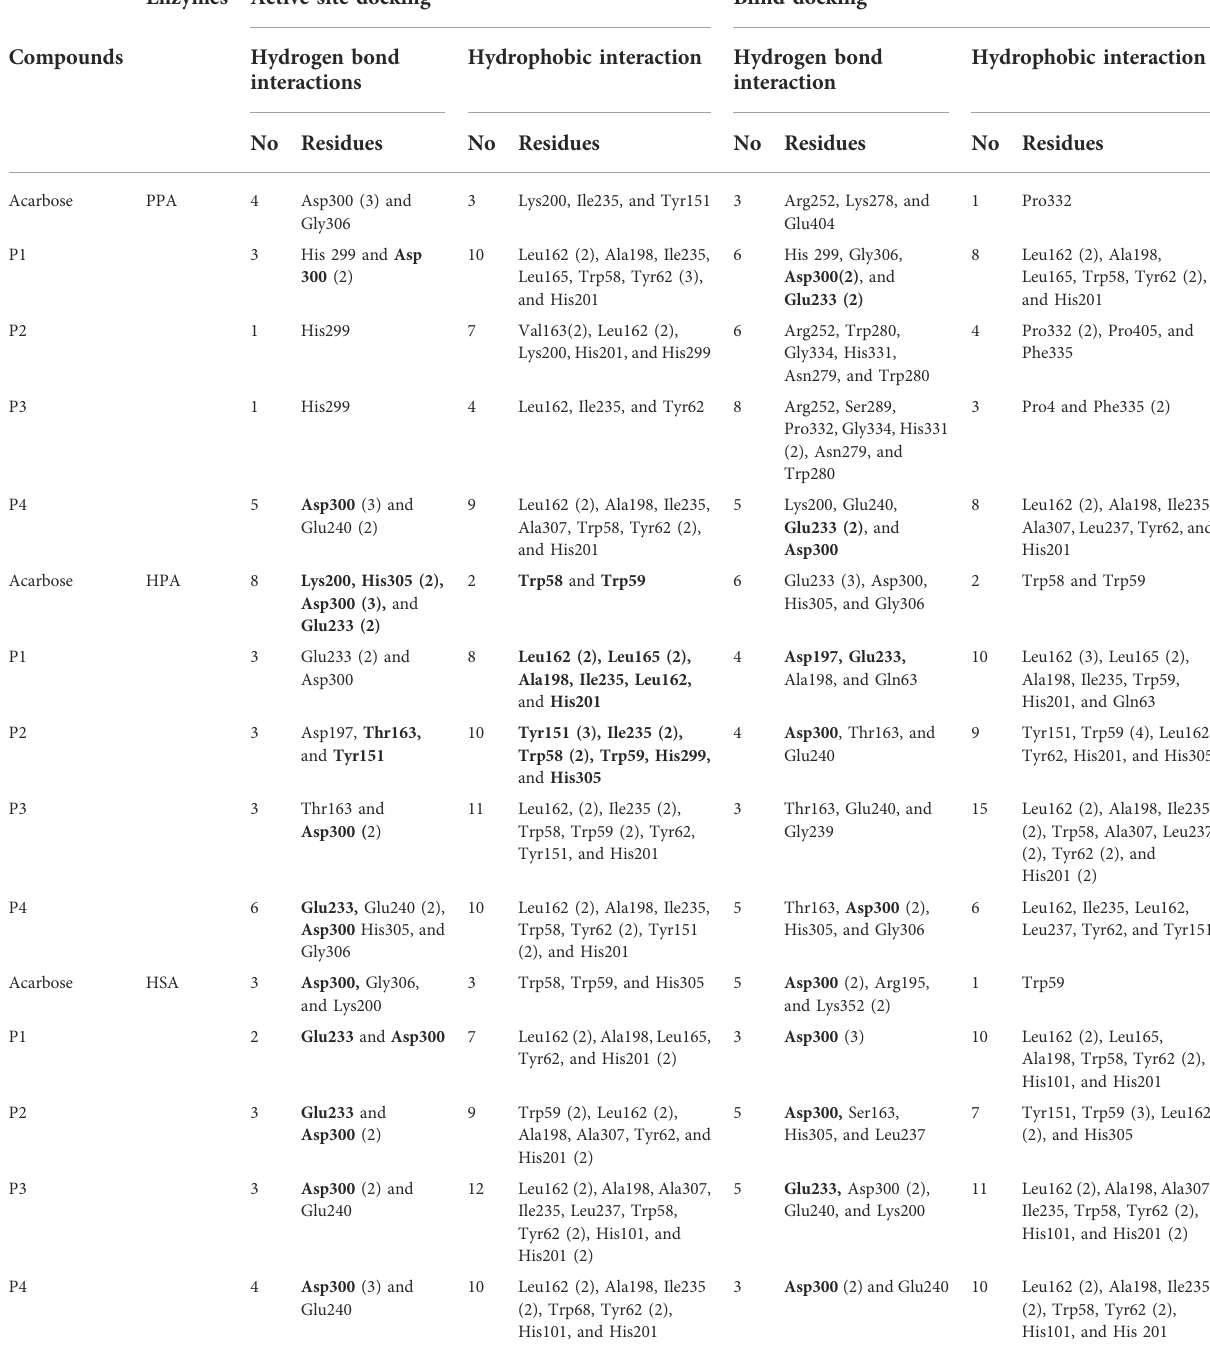
TABLE 2 Molecular interactions of porcine pancreatic alpha-amylase, human pancreatic alpha-amylase, and human salivary alpha-amylase with acarbose and the pregnane compounds (P1 – P4) derived from G. latifolium